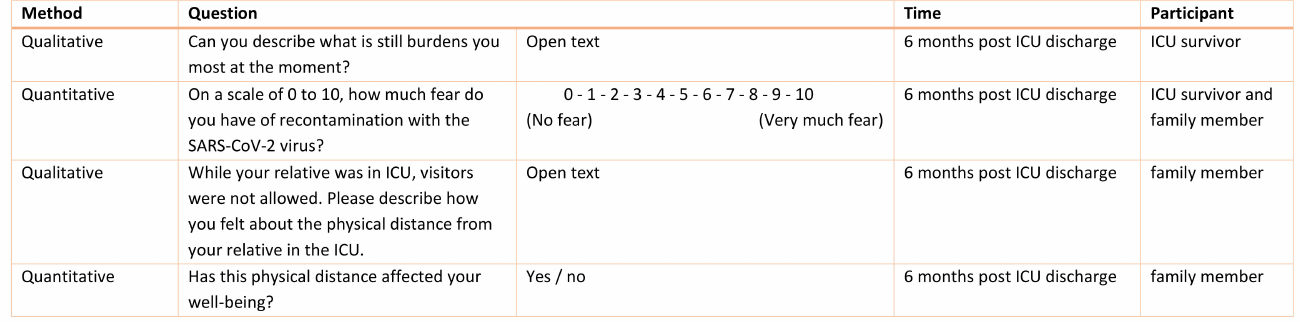
Figure A1. Overview of questions related to symptoms, fear of reinfection, post-influence of limited visiting possibilities and its influences on